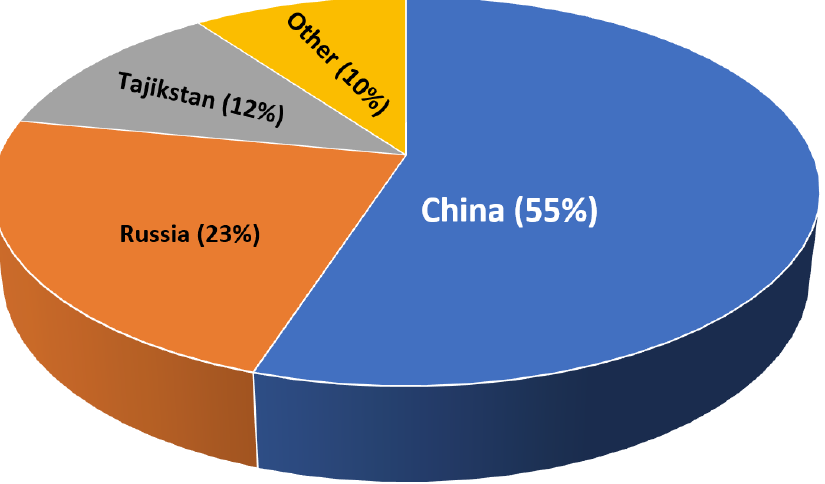
Figure 2. Countries with main mine production of antimony (adapted from [21]).